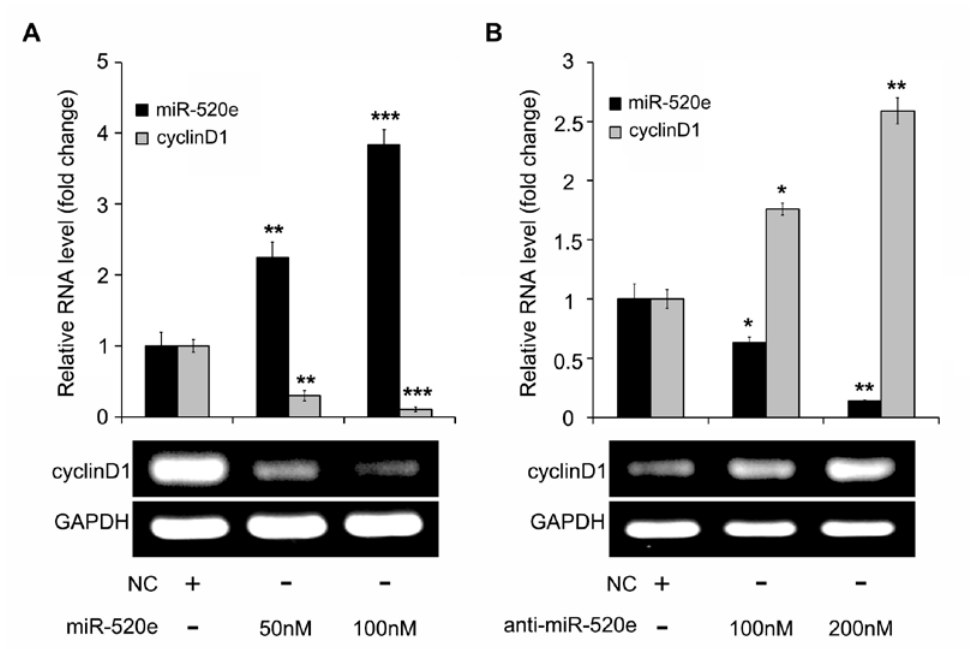
Figure 1: MiR-520e restrains the expression of cyclinD1 in breast cancer MCF-7 cells. (A, B) After miR-520e or anti-miR-520e was induced into MCF-7 cells, the level of cyclinD1 was determined by using RT-PCR assay of one-point detection in electrophoresis results and quantitative real-time PCR from a minimum of three different repeats for each sample. Meanwhile, the level of miR-520e in the cells transfected with miR- 520e and anti-miR-520e was evaluated by quantitative real-time PCR. Statistical quantification from at least three independent experiments